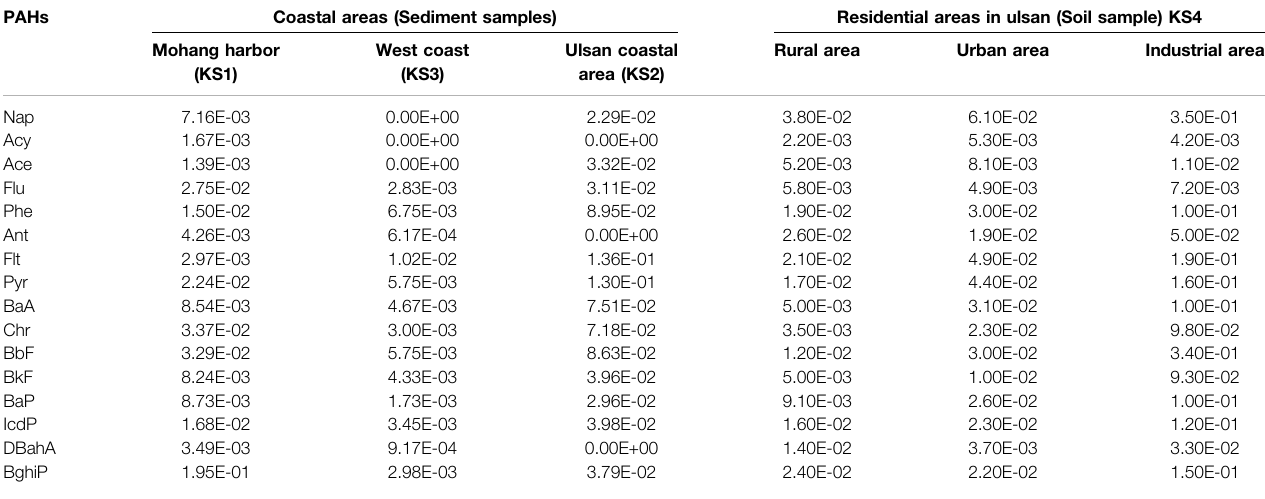
TABLE 3 | Mean PAH levels in the study coastal and residential areas. PAHs Coastal areas (Sediment